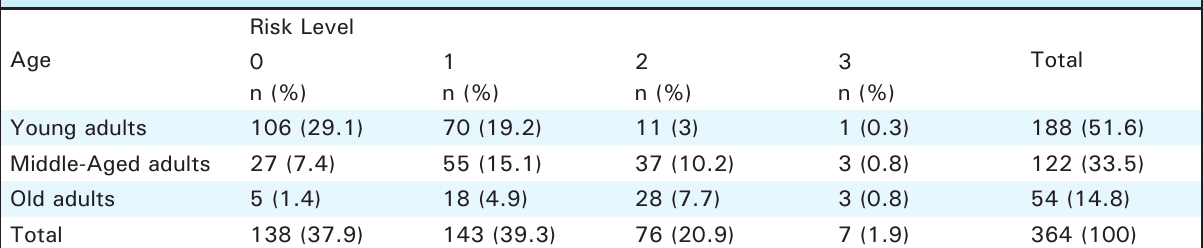
Table 3. Distribution of age group and tooth wear.